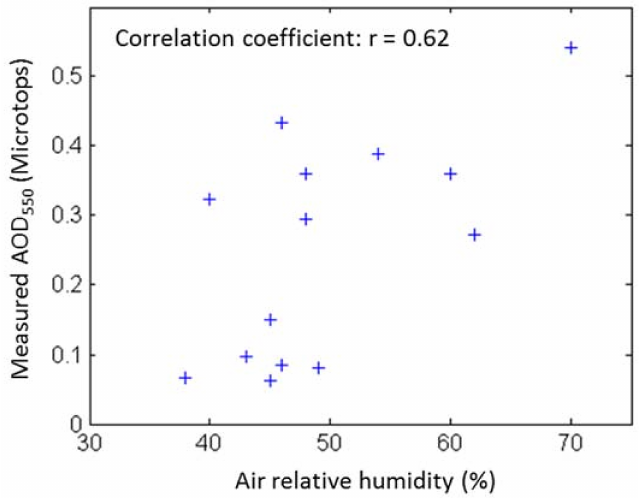
Figure 2. Relation between aerosol optical depth (AOD) at 550 nm measured by Microtops-II instrument in Mont é r é gie, Qu é bec, Canada, and relative humidity given by the closest meteorological station.